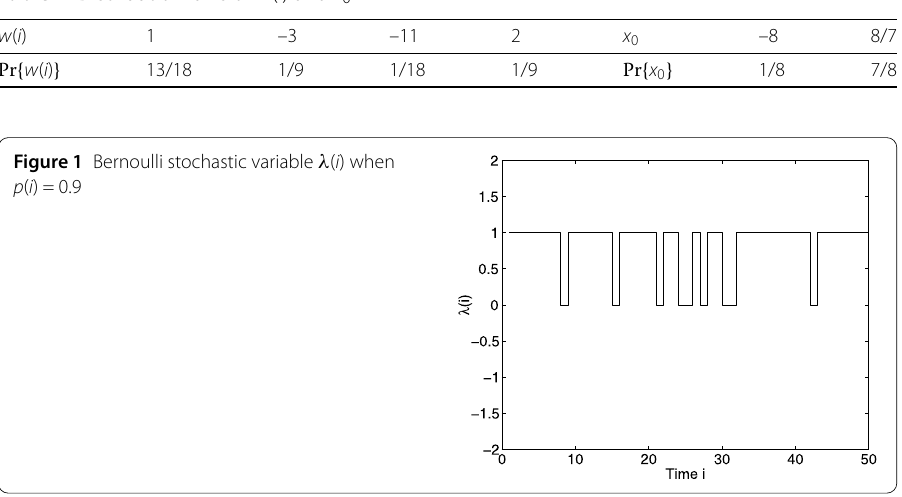
Table 1 Distribution laws of w ( i ) and x 0